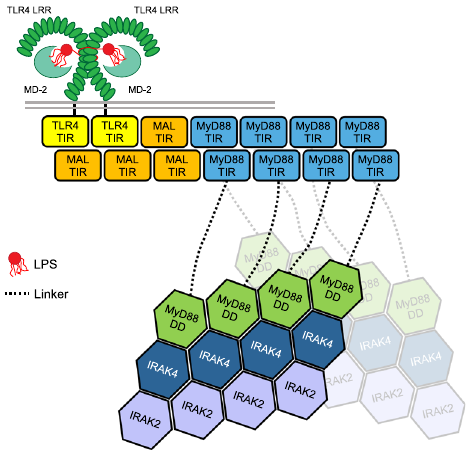
Fig. 1 Schematic diagram of the SCAF model for TLR signaling. Pathogen- associated molecular patterns (e.g., LPS) binding to the extracellular LRR domain of a TLR (e.g., TLR4) induces dimerization of its TIR domains, which leads to the recruitment of an adaptor TIR domain (e.g., MAL TIR ) to the extended surface created by the TLR4 TIR dimer. Elongation of this trimer through recruiting additional adaptor ’ s TIR domains (e.g., MAL TIR or MyD88 TIR ) into a higher-order complex leads to clustering of MyD88 DDs and subsequent recruitment of IRAKs through DD interactions. The initial TIR dimerization and trimerization steps are likely to be unfavourable and rate limiting, whereas subsequent monomer additions are more favourable, rapid and cooperative. LRR, leucine-rich repeat domain; LPS, lipopolysaccharide; TLR, Toll-like receptor; TIR, Toll/interleukin-1 receptor domain; DD, death